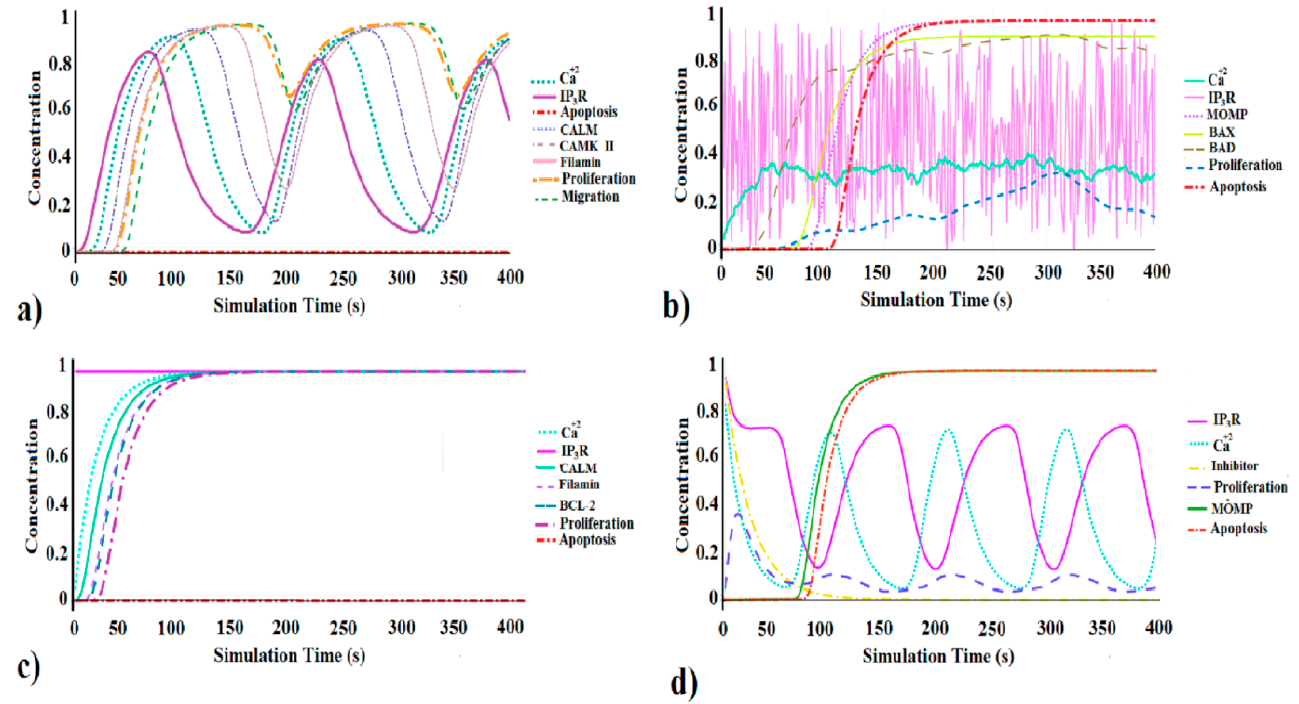
Figure 2. Dynamic simulations of the biological regulatory network of IP 3 R by Jimena showing the effect of IP 3 R mediated Ca +2 effluxes in the regulation of cell proliferation and apoptosis. The time (s) is shown on the x -axis and the relative activity of oncogenes and tumor suppressors, in terms of concentration, is shown on the y -axis. ( a ) Simulation results of normal IP 3 R function and its impact on cell growth & apoptosis. ( b ) Simulation results of perturbed IP 3 R in normal cell and resultant apoptosis and cell proliferation. ( c ) Simulation of highly active IP 3 R in the cancer cell. ( d ) Dynamic simulation results of IP 3 R network in a cancer cell in presence of inhibitor showing the effect of inhibitors upon cell proliferation and apoptosis.